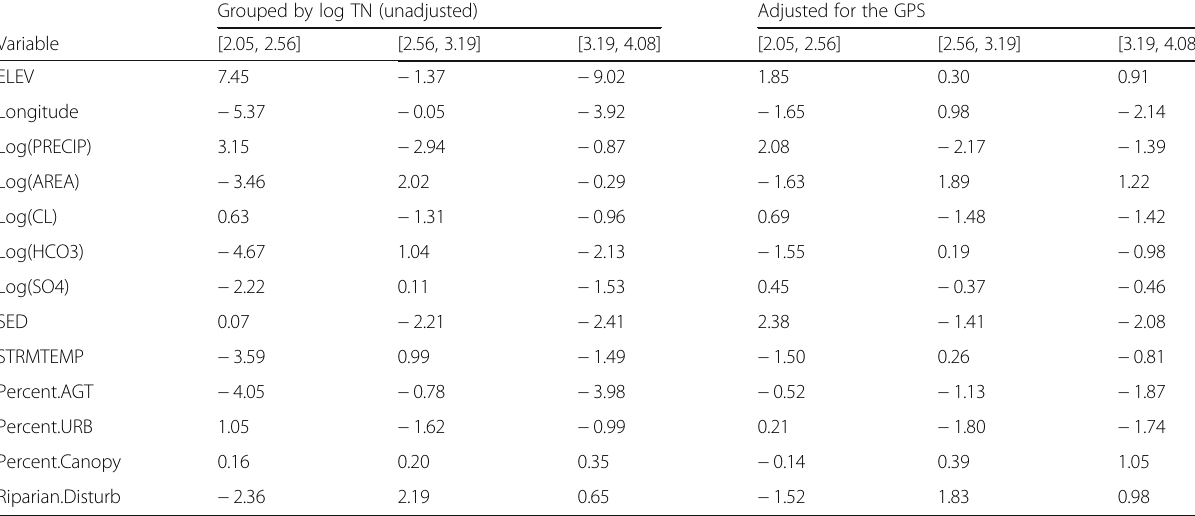
Table 5 Standardized mean differences between one group and the other two combined for the Great Plains ecoregion Grouped by log TN (unadjusted) Adjusted for the GPS